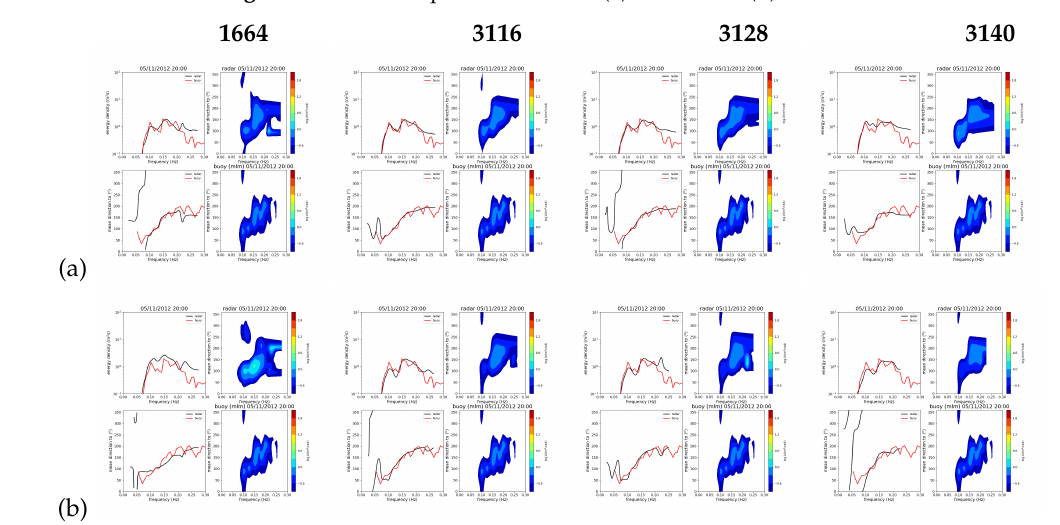
Figure 19. Inverted spectra for case 4. ( a ) monostatic ( b ) 1 bistatic.